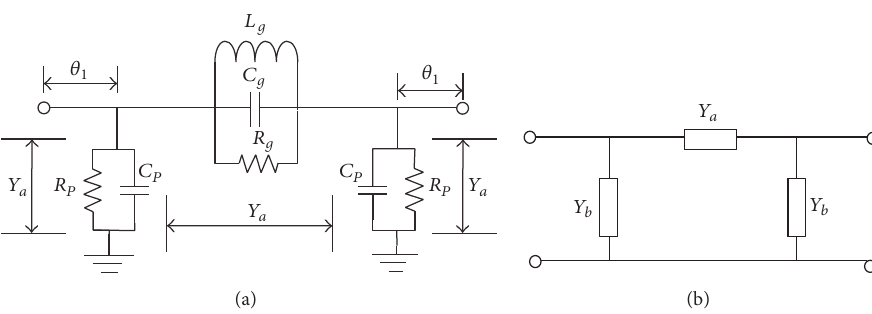
Figure 6: 𝜋 shaped equivalent circuit for unit DGS: (a) equivalent circuit; (b) 𝜋 shaped circuit [31].